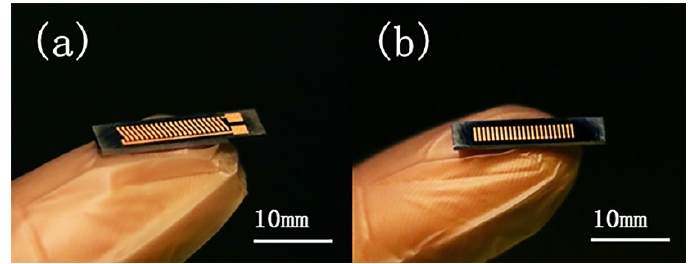
Figure 5. ( a ) Upper and ( b ) lower surfaces of the coil obtained by sintering the pre-alloyed powder after surface cleaning.